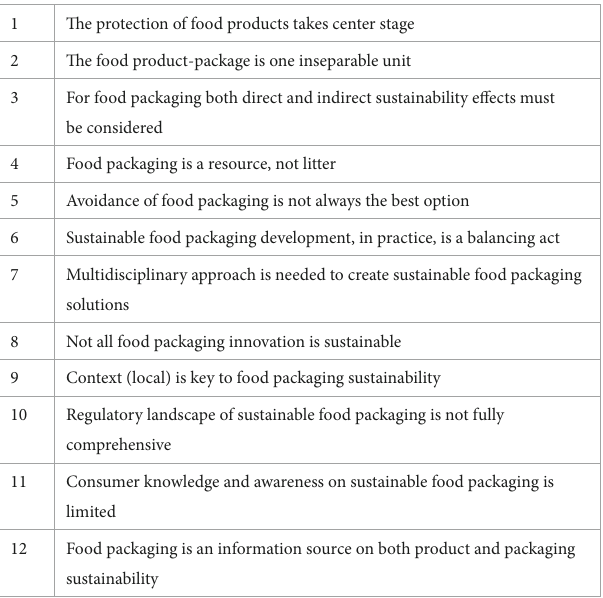
TABLE 2 Review of challenges for sustainable packaging